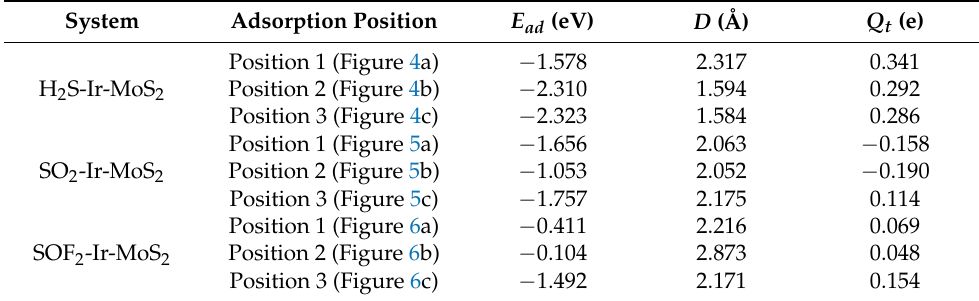
Figure 6. Adsorption systems of SOF 2 -Ir-MoS 2 in different positions. Table 1. The adsorption parameters of Ir-modified MoS 2 for various gases in different positions.